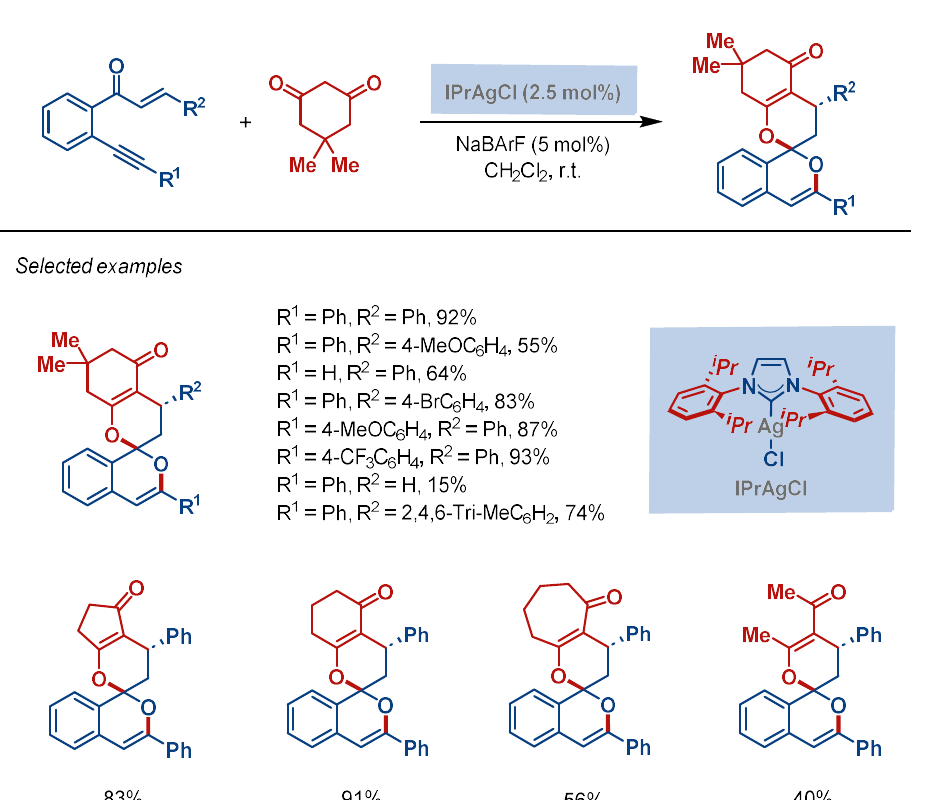
Scheme 7. Ag(I)−NHC-catalyzed intramolecular 6- endo - dig cyclization to form 6-membered